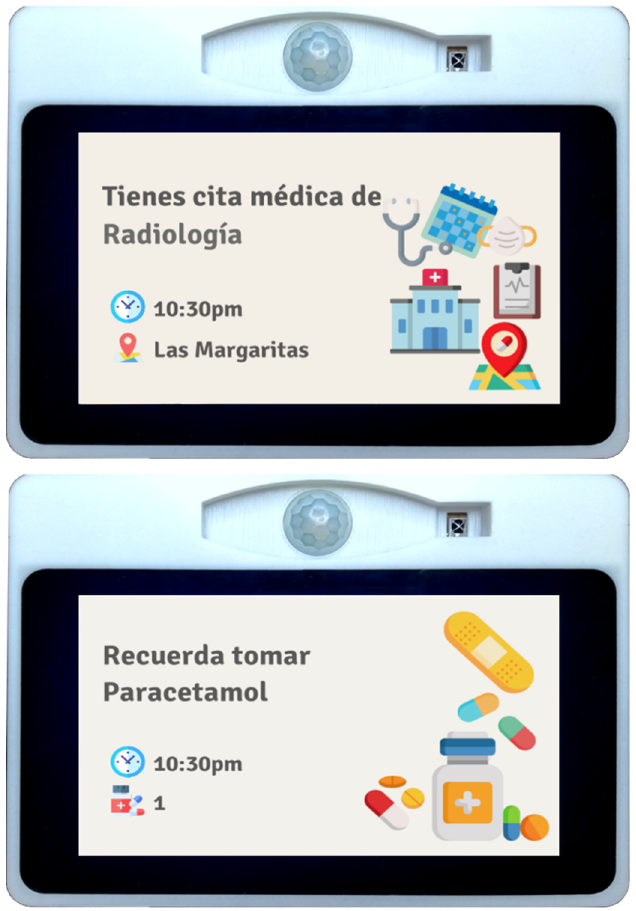
Figure 21. Home IoT device notification screen.